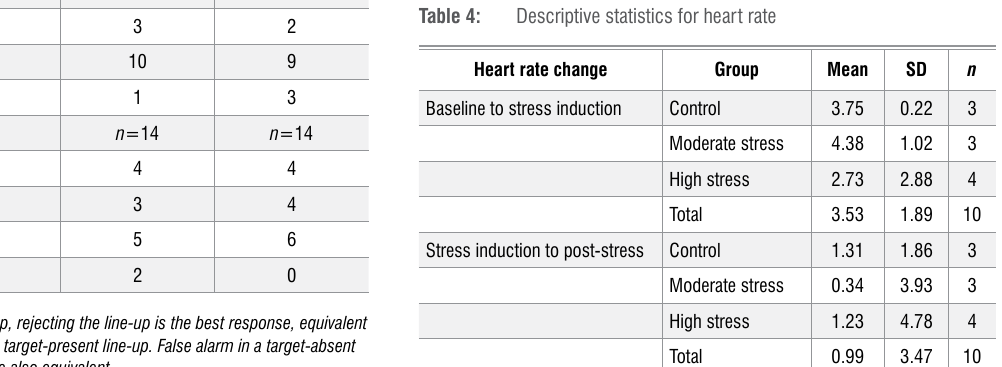
Table 3: Line-up responses by stress condition for target-absent and target-present line-ups MAST Placebo Target absent n =14 n =14